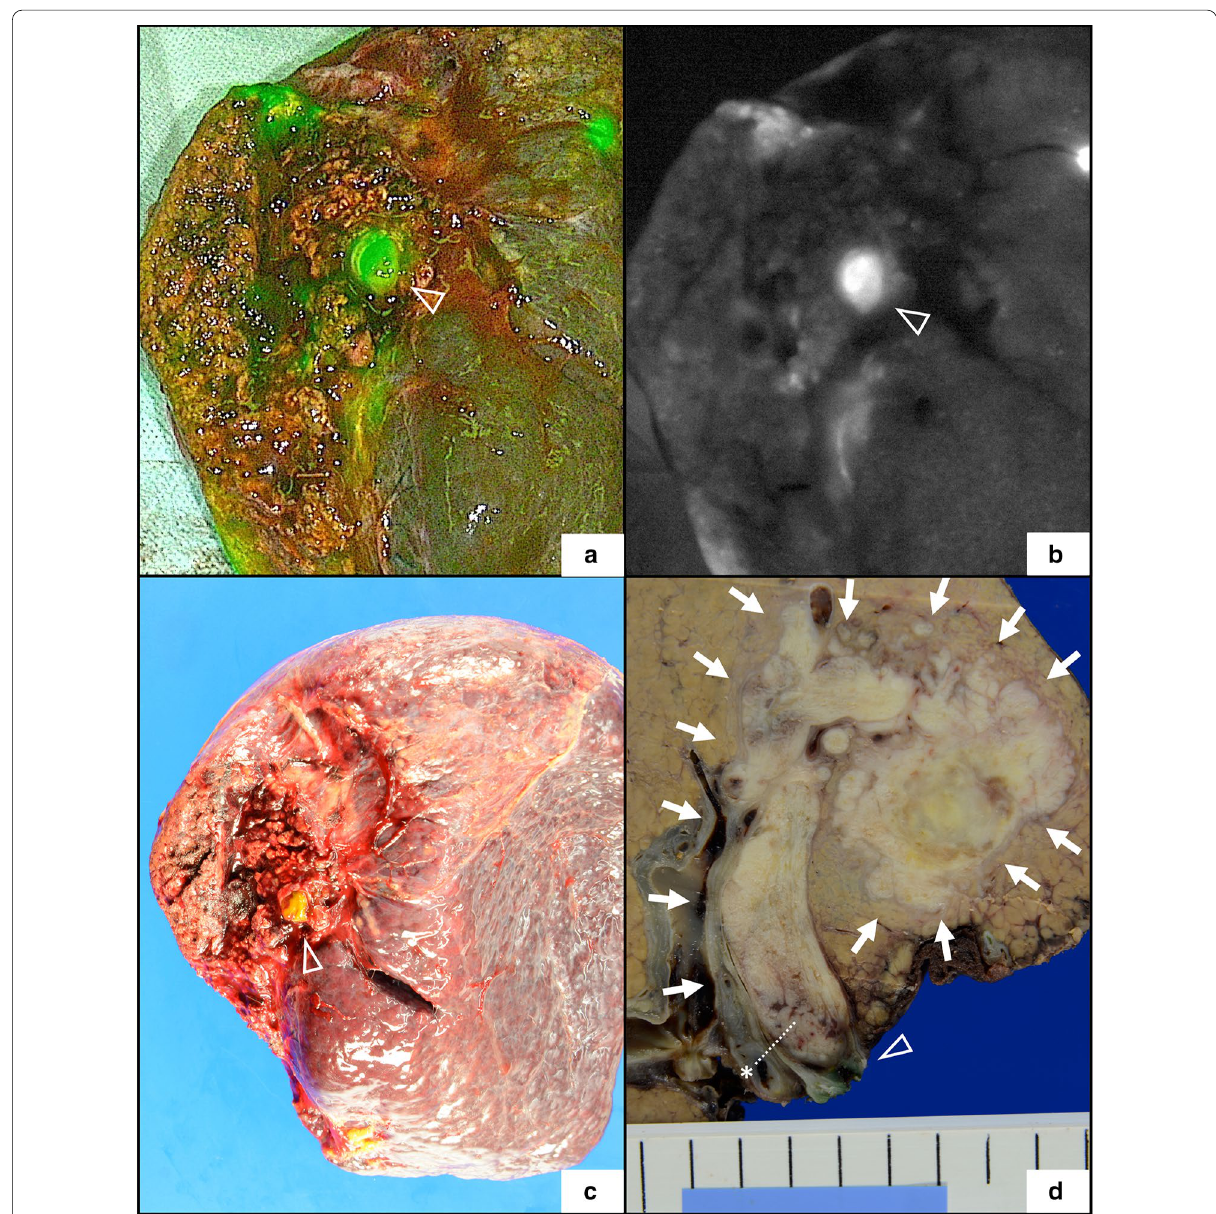
white-black mode). Bile duct tumor thrombus (BDTT) emitted strong fluorescence. Arrow head: The tip of BDTT at the stump of the right hepatic duct. c Gross findings of the resected specimen. Arrow head: The tip of BDTT at the stump of the right hepatic duct. d Cut surface of the resected specimen with secured surgical margin at the right hepatic duct. Arrow: tumor, asterisk: The tip of BDTT, arrow head: The stump of the right hepatic